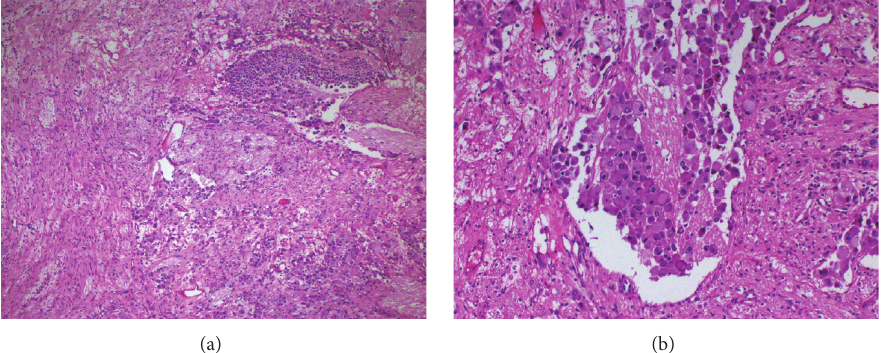
Figure 3: Photomicrographs showing more than 50% of tumor tissue in this case composed of Schwannian stroma and neuropil-like islands, differentiating neuroblasts, and immature and dysplastic ganglion cells. H&E (a and b), original magnification (a) 10x and (b)